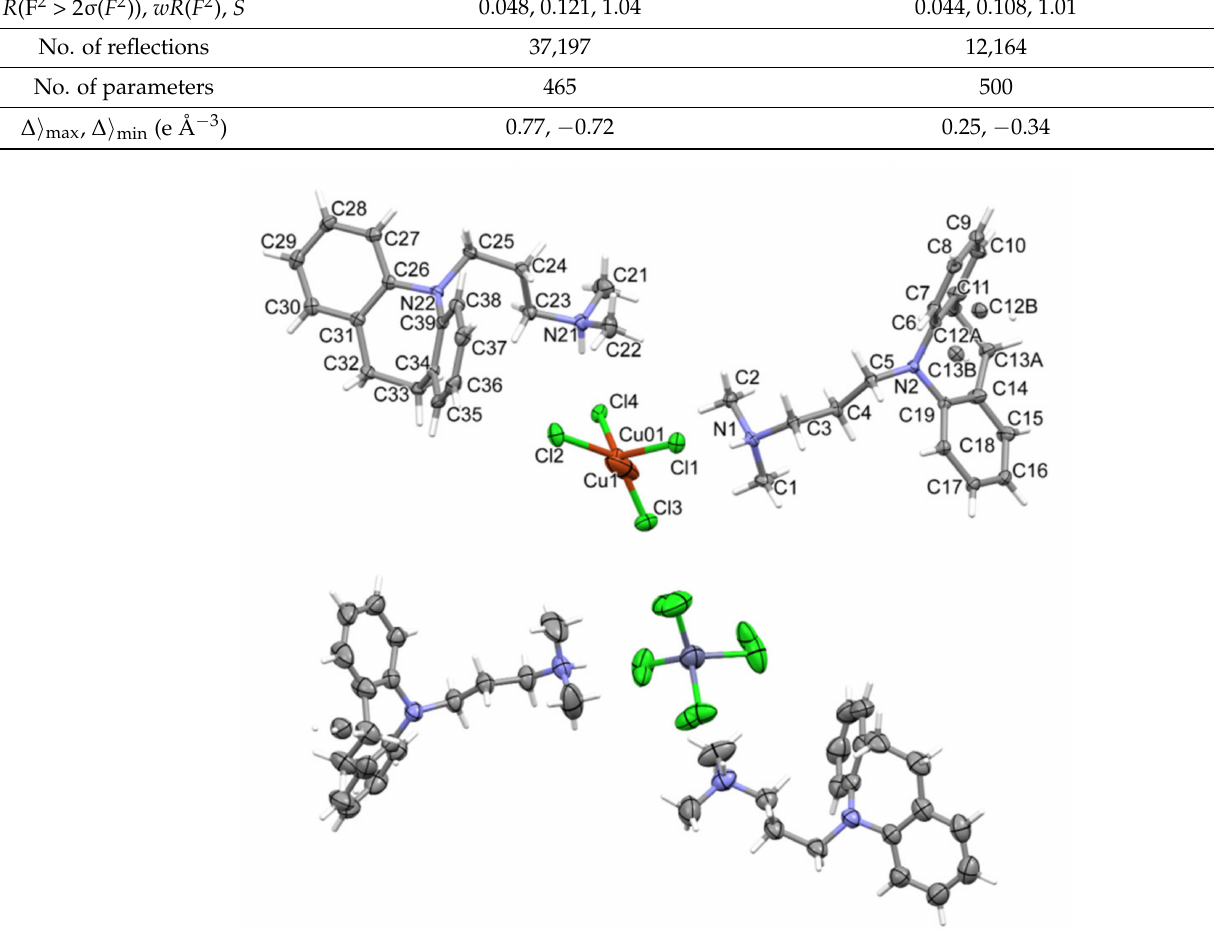
Figure 1. The molecular structures of the [HL] 2+ [CuCl 4 ] 2 − compound showing the atom-labelling schemes (above) and the [HL] 2+ [ZnCl 4 ] 2 − compound